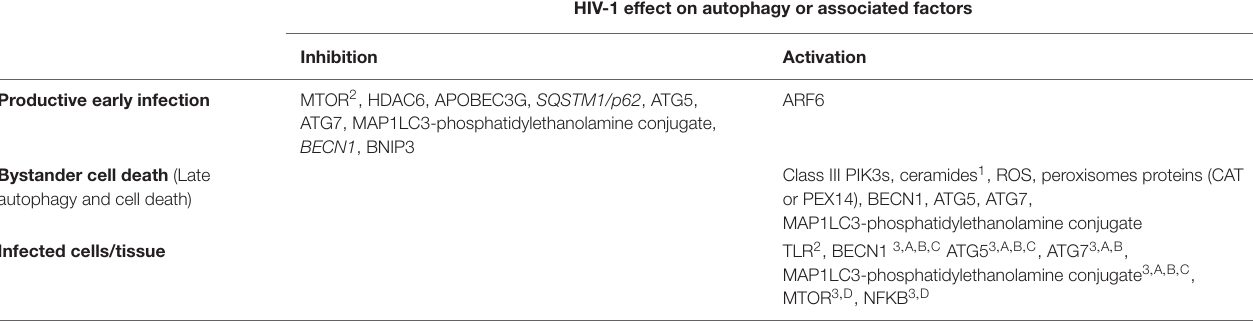
TABLE 1 | Summary of the HIV-1 effect on autophagy or associated